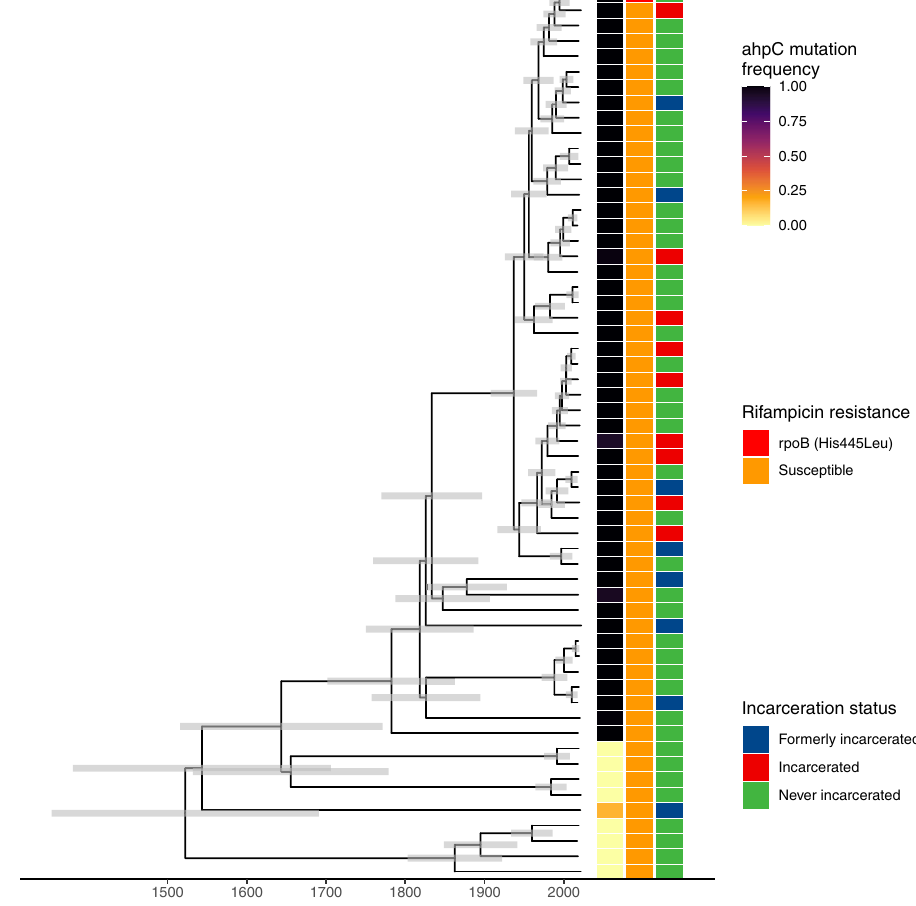
Fig. 5 | Emergence of a putative resistance-associated ahpC promoter muta- tion. Time-scaled Bayesian maximum clade credibility tree for 58 samples in sub- lineage4.4.1.1.Branchlengthsareinyearsandgreybarsindicate95%highposterior densityestimatesofnodedate.Theheatmaptotherightofthephylogenyindicates